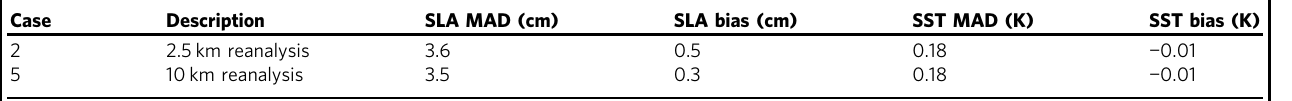
Table 3 Average analysis innovation statistics for 2006 – 2008 in the Tasman Sea